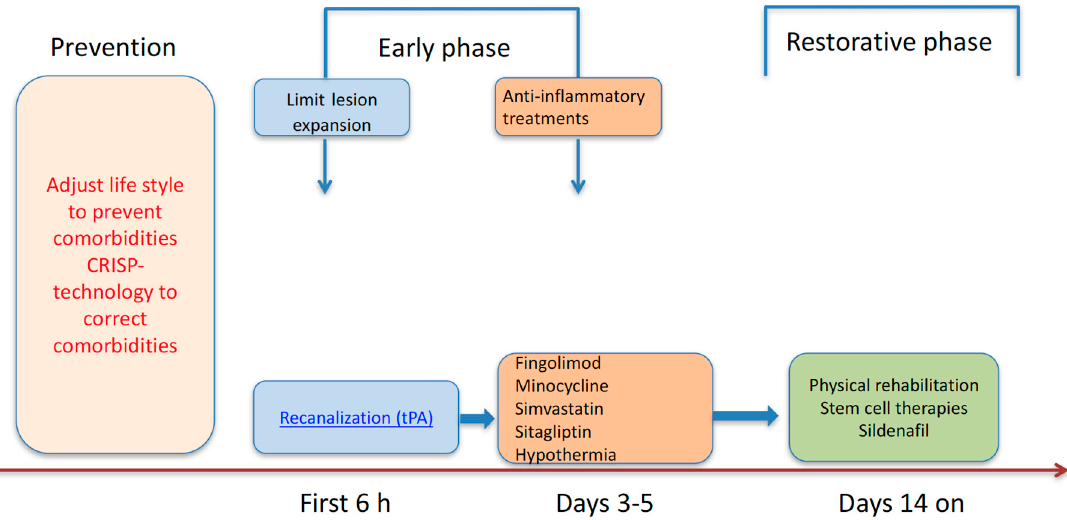
Figure 1. Stage-specific therapeutical approaches in humans and animal models.